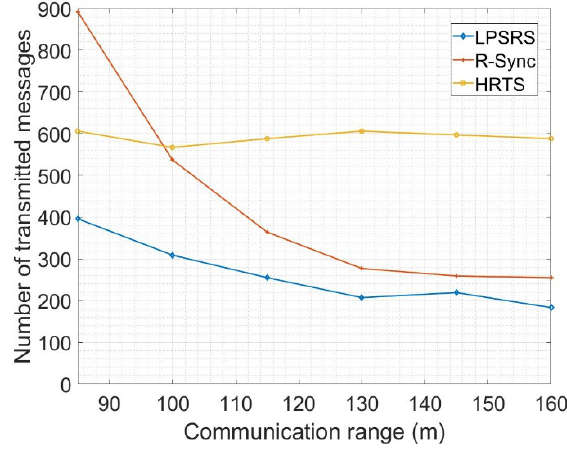
= 85 m: 160m, N = 240). Figure 8. Required number of messages ( r = 85 m: 160 m, N = 𝑟𝑟